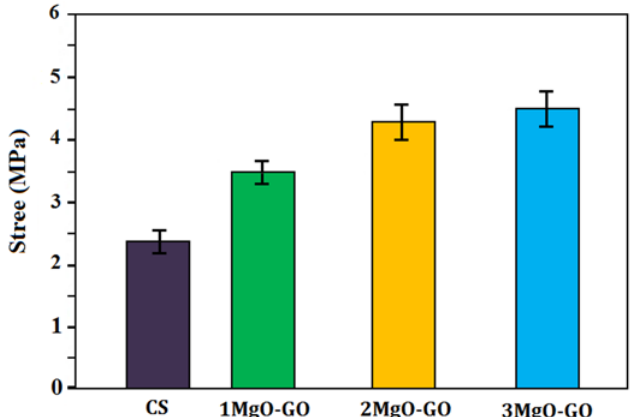
Figure 6. Bond strengths of CS, CS/1MgO ‐ GO, CS/2MgO ‐ GO, and CS/3MgO ‐ GO coated Mg alloys.